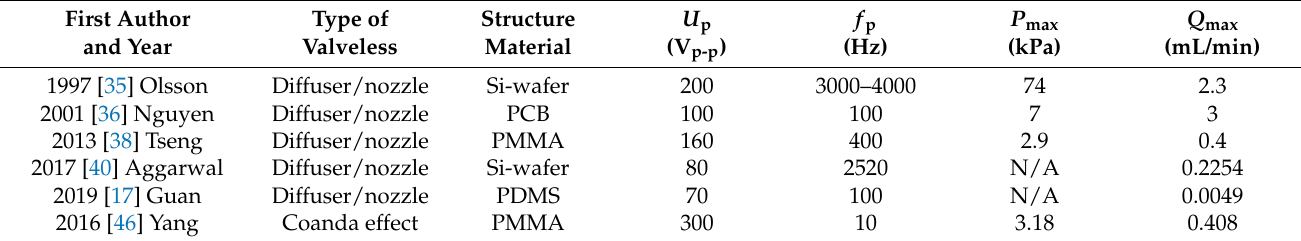
Table 1. Summary of properties for the valveless piezoelectric pump with external flow tubes.